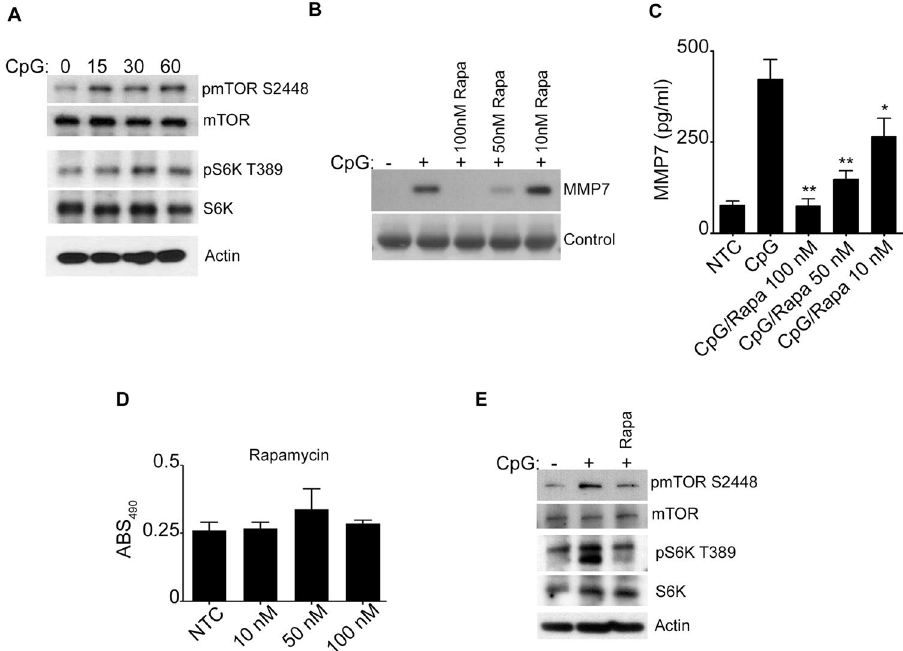
Figure 4. CpG-mediated MMP-7 activation by B-lymphocytes requires the mTOR pathway. ( A ) Phosphorylation of mTOR and pS6K was detected by immunoblotting in the cell lysate of CpG-stimulated cells. Rapamycin at the concentrations shown was used prior to stimulation, and then MMP-7 was measured by immunoblotting ( B ) and ELISA ( C ) in the cell supernatant. ( D ) XTT was measured after 24 hours in the presence of different concentrations of Rapamycin. ( E ) Phosphorylation of mTOR and pS6K was detected by immunoblotting in the cell lysate. Some cells were pretreated with (100 nM) Rapamycin prior to